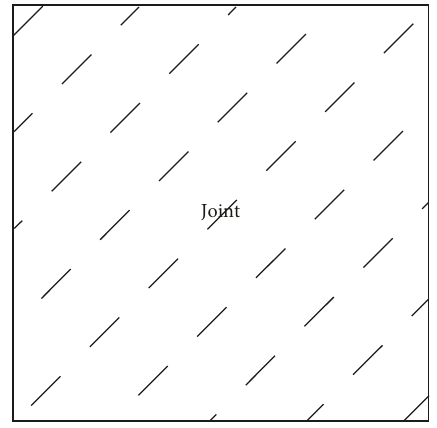
Figure 21: Sketch of a single group of